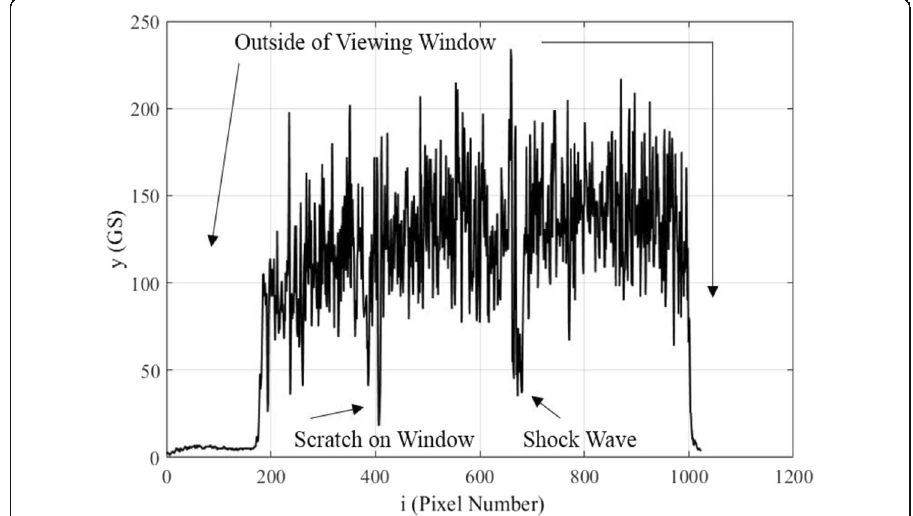
Fig. 9 Grayscale value variation with horizontal pixel location of the last frame in the time sequence for vertical pixel 277 for data acquired on 05 April